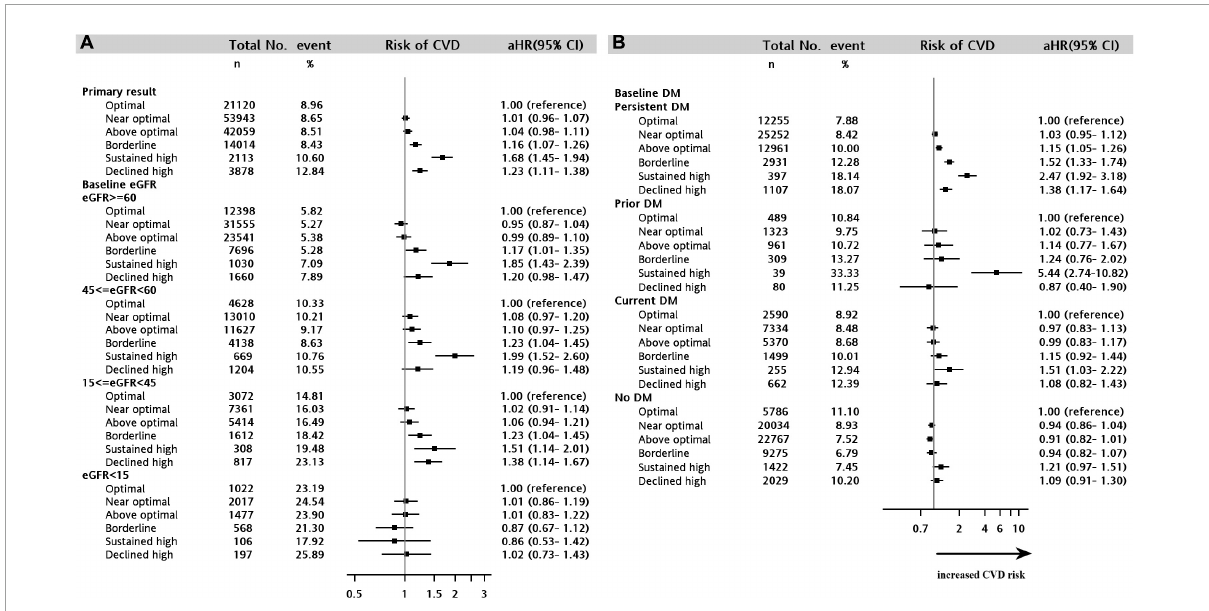
FIGURE2 Forest plot showing the adjusted hazard ratio for cardiovascular disease among the LDL-C trajectory classes in the stratified analyses. (A) CKD cohort stratified by estimated glomerular filtration rate strata. (B) CKD cohort stratified by diabetes scenario. CKD, chronic kidney